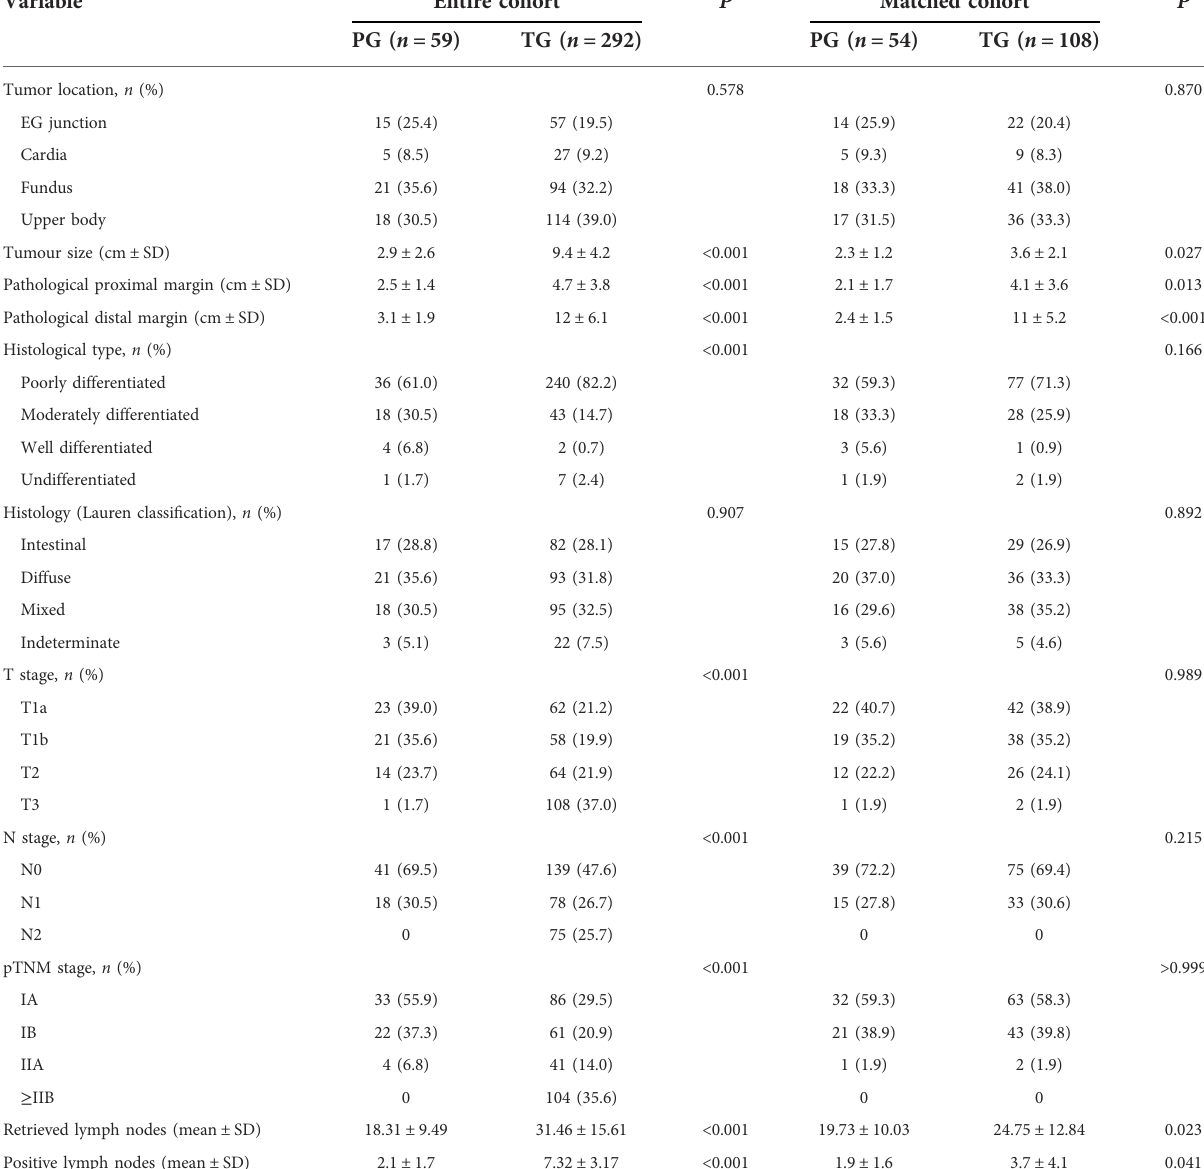
TABLE 3 Histopathologic